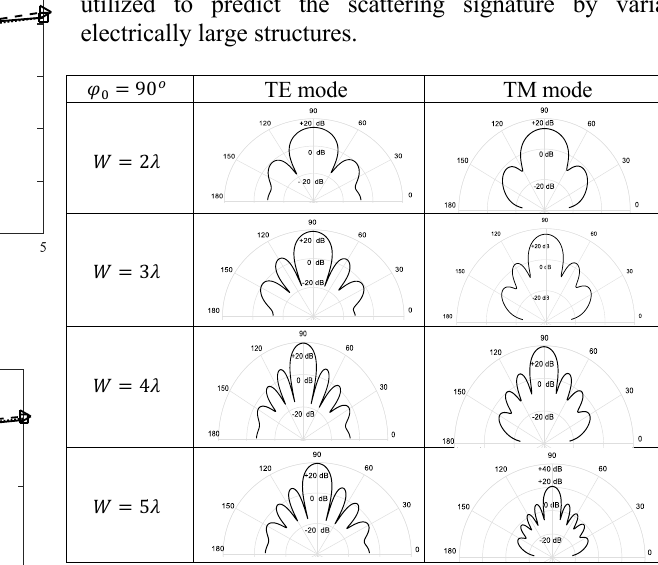
Fig.5. Bistatic echowidth patterns at 𝜑 60 (cid:135) for the various IRTG widths 𝑊 = 𝜆, 2𝜆, 3𝜆 , and 4𝜆 𝑊 = 4𝜆 TE mode TM mode = Q# ) at = 𝜀 , 𝜇 = 𝜇 F A F A